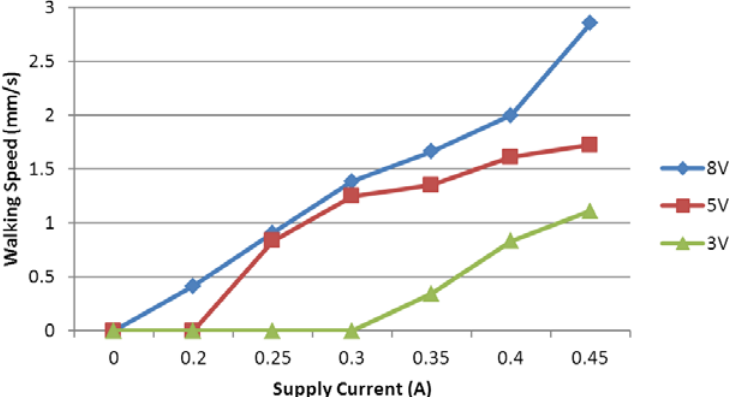
Figure 22. Experimental walking speeds with different